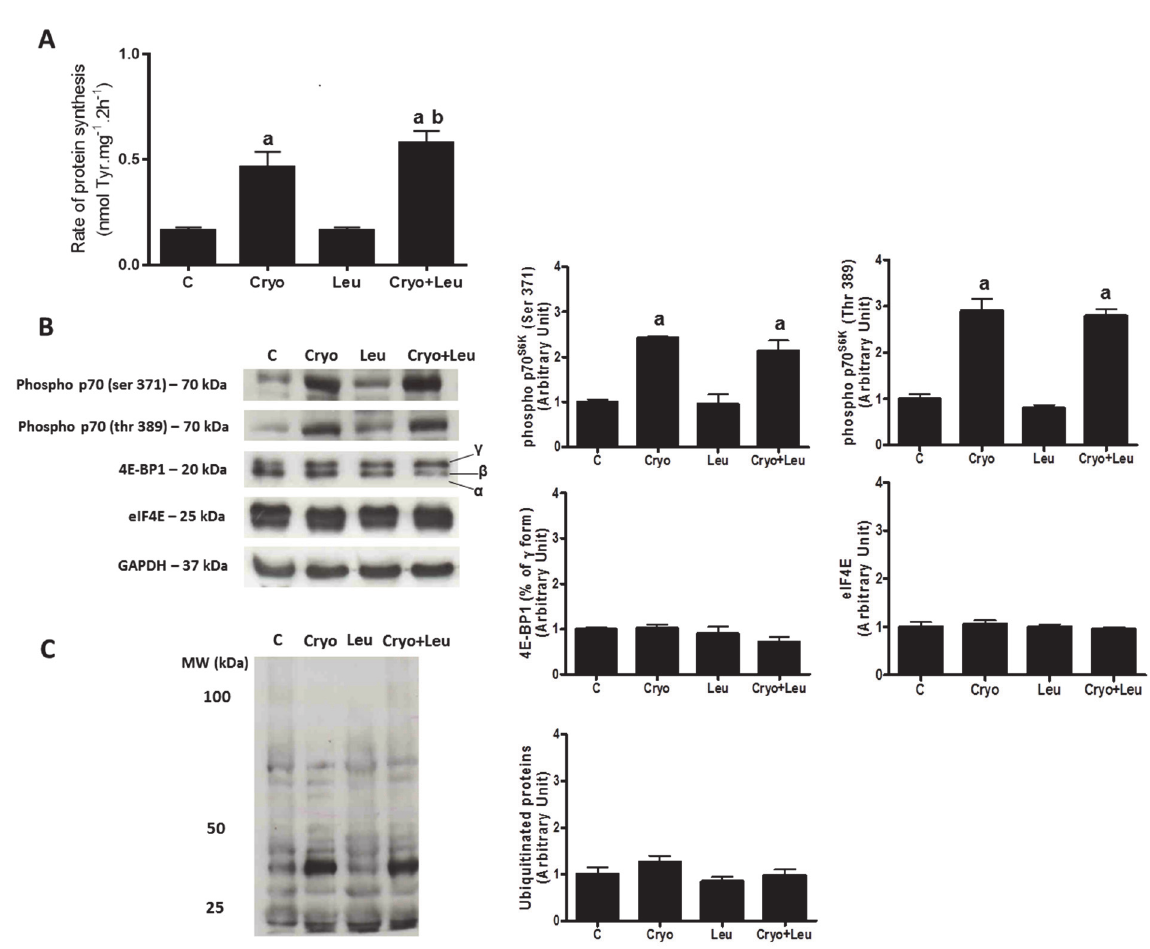
Figure 4. The rate of protein synthesis in extensor digitorum longus (EDL) muscles analyzed on post-cryolesion Day 10 (nmol Tyr·mg − 1 ·2 h − 1 ; ( A )). Representative western blots and densitometry analyzes of elements within the PI3K/Akt/mTOR pathway ( B ) and ubiquitinated proteins accumulation ( C ) from TA muscles on post-cryolesion Day 10. Muscle groups are identified at the top. C, control muscles; Cryo, muscles analyzed on post-cryolesion Day 10; Leu, muscles after 13 days of leucine supplementation; Cryo + Leu, leucine supplemented group analyzed on post-cryolesion Day 10. GAPDH was used as the standard. Western blot data are expressed as the fold of protein expression detected in C group. Molecular weight is presented in kDa. a p < 0.05 vs. C and